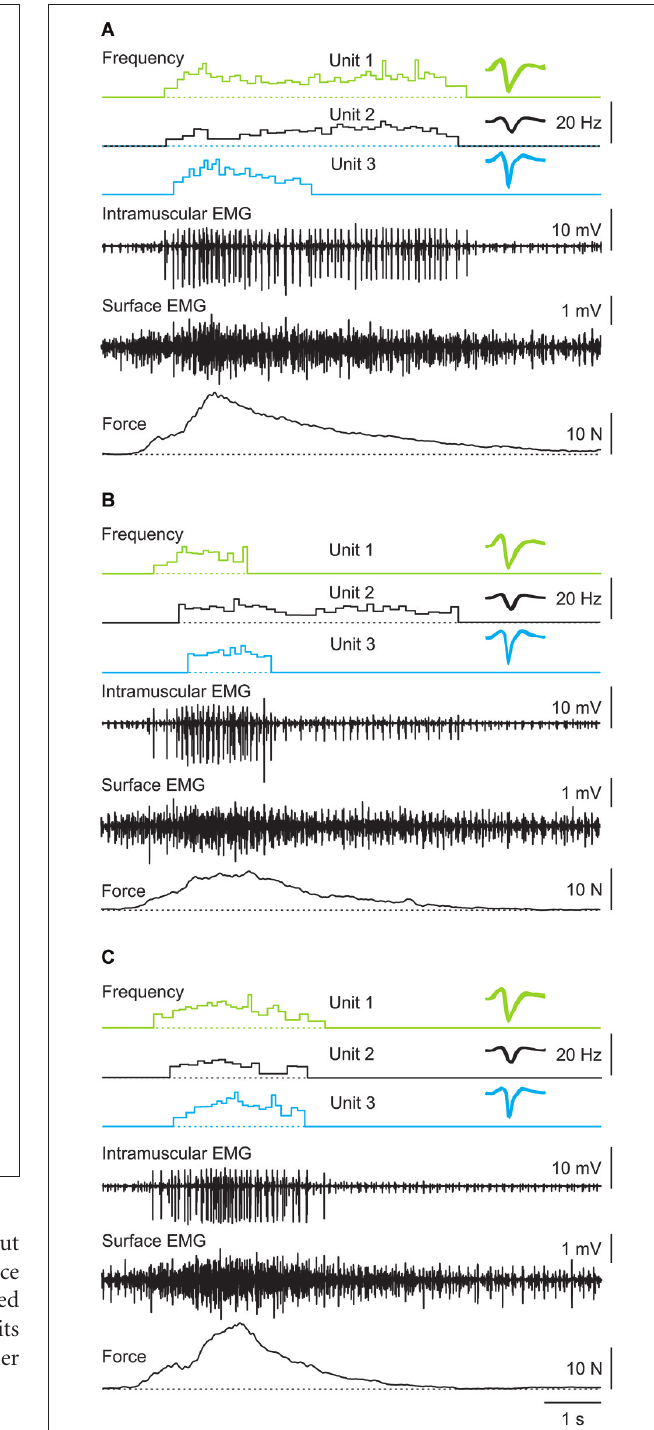
FIGURE 3 | Three consecutive muscle spasms from one subject in which three coactive units behaved differently despite similar rates of force increase and decrease during each spasm . Recruitment order was always Unit 1, 2, then 3. Unit derecruitment occurred in the reverse order in two spasms (A,C) but was disordered (Unit 1, 3, 2) in the other spasm (B) . Overlays of the marked potentials show accurate identification of each motor unit